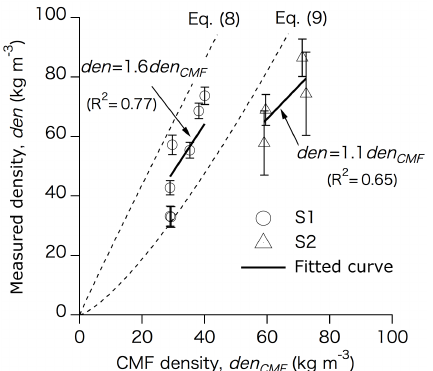
Figure 11. Relationships between the measured density and CMF density for the S1 (empty circle) and S2 (empty triangle) groups. Solid lines and equations represent the approximated relationships. The dotted lines show the same relationships as Fig. 10, correspond- ing to Eqs. (8) and